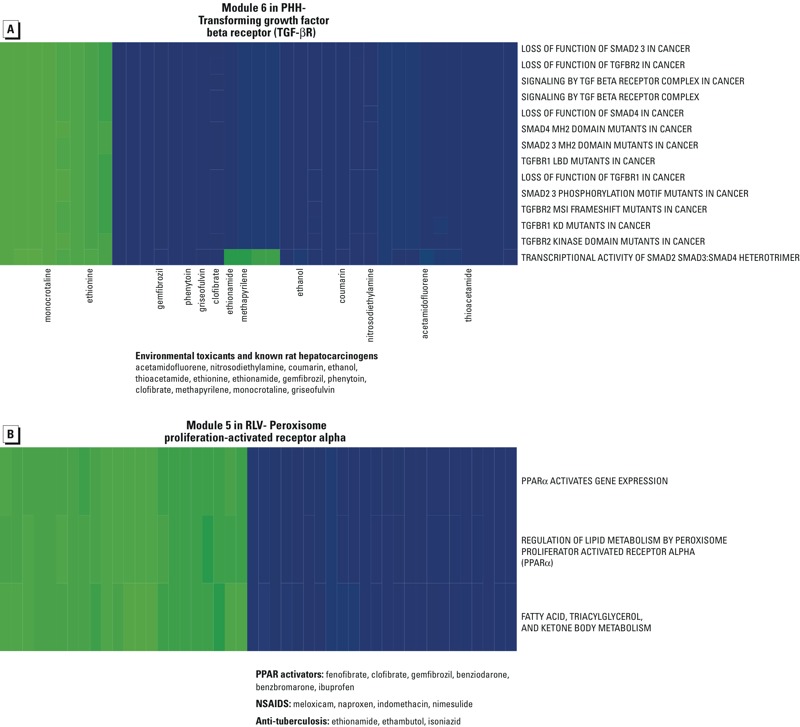
Characterization of putative biomarkers within chemical-induced modules. (A) Heatmap representing a module in PHH (mod6), associated with transforming growth factor beta receptor signalling, that can be considered as a candidate biomarker in humans for environmental exposure to known toxicants. Diverse rat hepatocarcinogens were enriched in this module. (B) Heatmap representing a module in RLV (mod5) that was relevant to toxicity mode of action and is enriched for a class of lipid-lowering drugs known as fibrates. These drugs are rat hepatocarcinogens and activate the peroxisome proliferation-activated receptor alpha (PPARα). Green, down-regulation; blue, up-regulation. Drugs that activate PPAR pathways include nonsteroidal anti-inflammatory and antituberculosis drugs. All statistical details and genes contributing to these pathways are in Supplemental Material, Zip file S4.